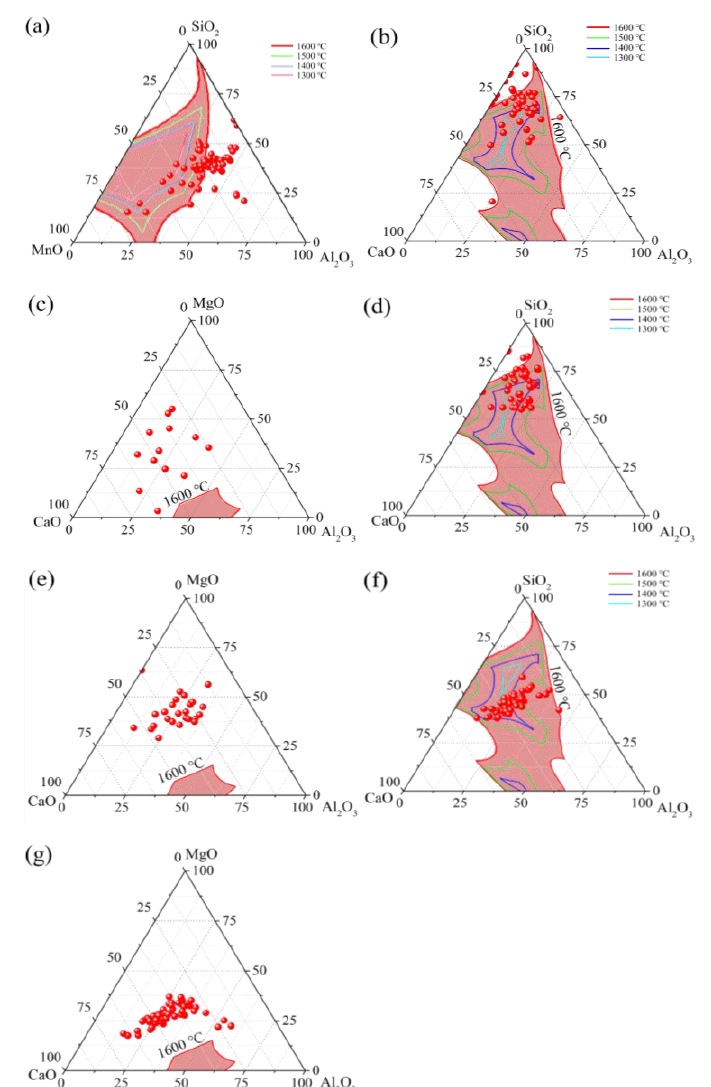
Figure 5. Composition distribution of inclusions in scheme B. ( a ) B-S1; ( b ) B-S2; ( c ) B-S2; ( d )